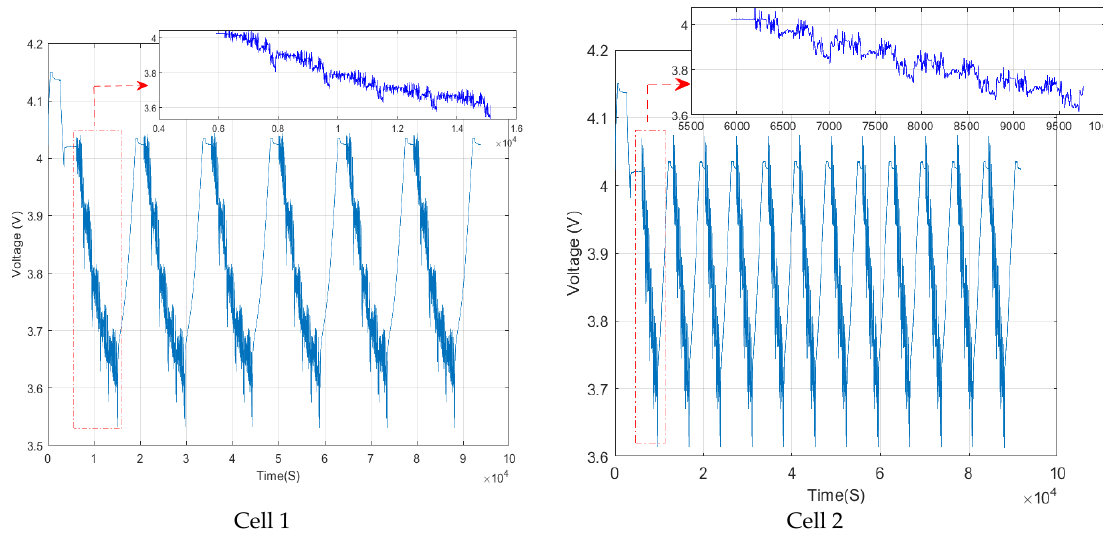
Figure 3. Recorded voltage data in one day of experiment for Cell One and Two.